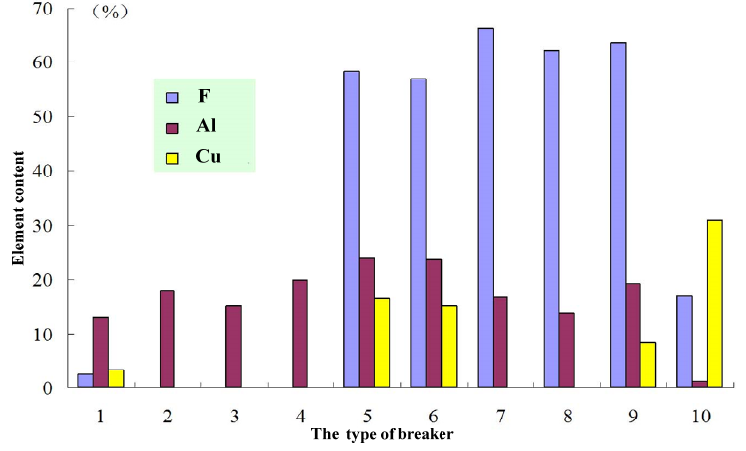
Figure 8. Elemental content analysis of solid powder in switchgear.